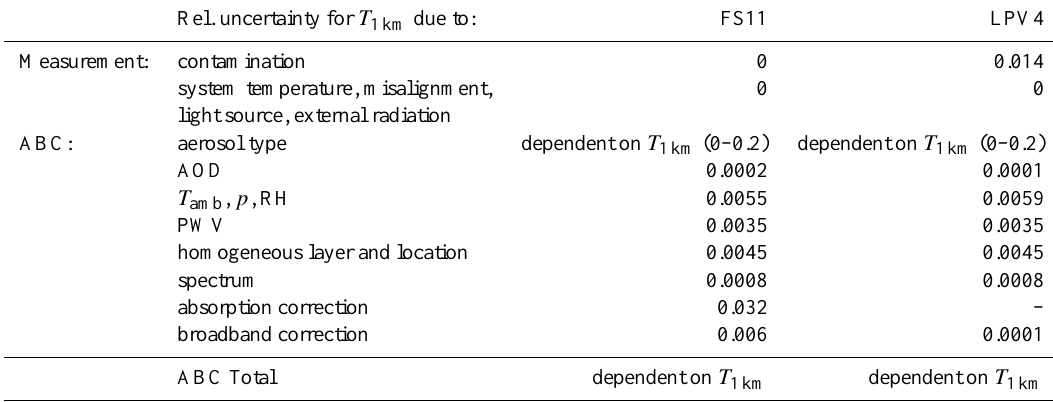
Table 2. Calculated and estimated relative uncertainties for FS11 and LPV4 measurements and the ABC method. Rel. uncertainty for T 1km due